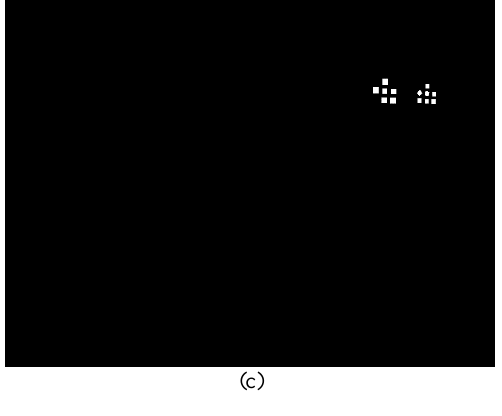
Figure 8. Result of edge detection.